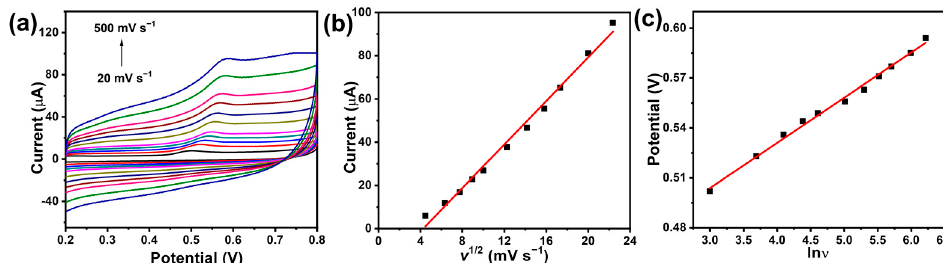
Figure 5. Various scan rates ( a ) on the oxidation peak current of BPA (0.1 mM) in 0.1 M phosphate buffer (pH 7.0). The relationship between peak current and scan rate ( b ). The plot of peak potential ( E pa ) vs. natural logarithm of scan rate (ln v ) ( c ). ( E pa ) vs. natural logarithm of scan rate (ln v ) ( c